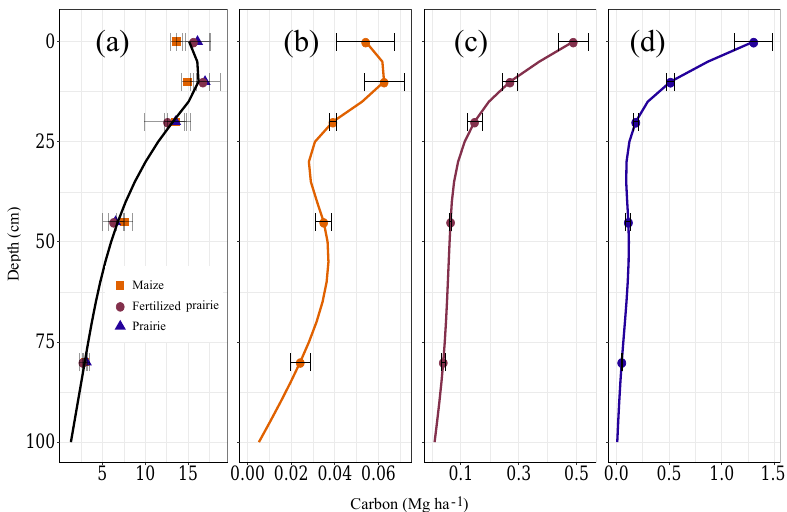
Figure 1. (a) Total soil carbon with each treatment represented by a point and the site average represented by a solid line for (b) maize root carbon, (c) fertilized prairie root carbon, (d) and unfertilized prairie root carbon measured in 2013, which is 6 years after the establishment of the experiment. Different x -axis scales are used to emphasize similarities and differences in profile distribution patterns, not absolute mass amounts (see Fig. 2).